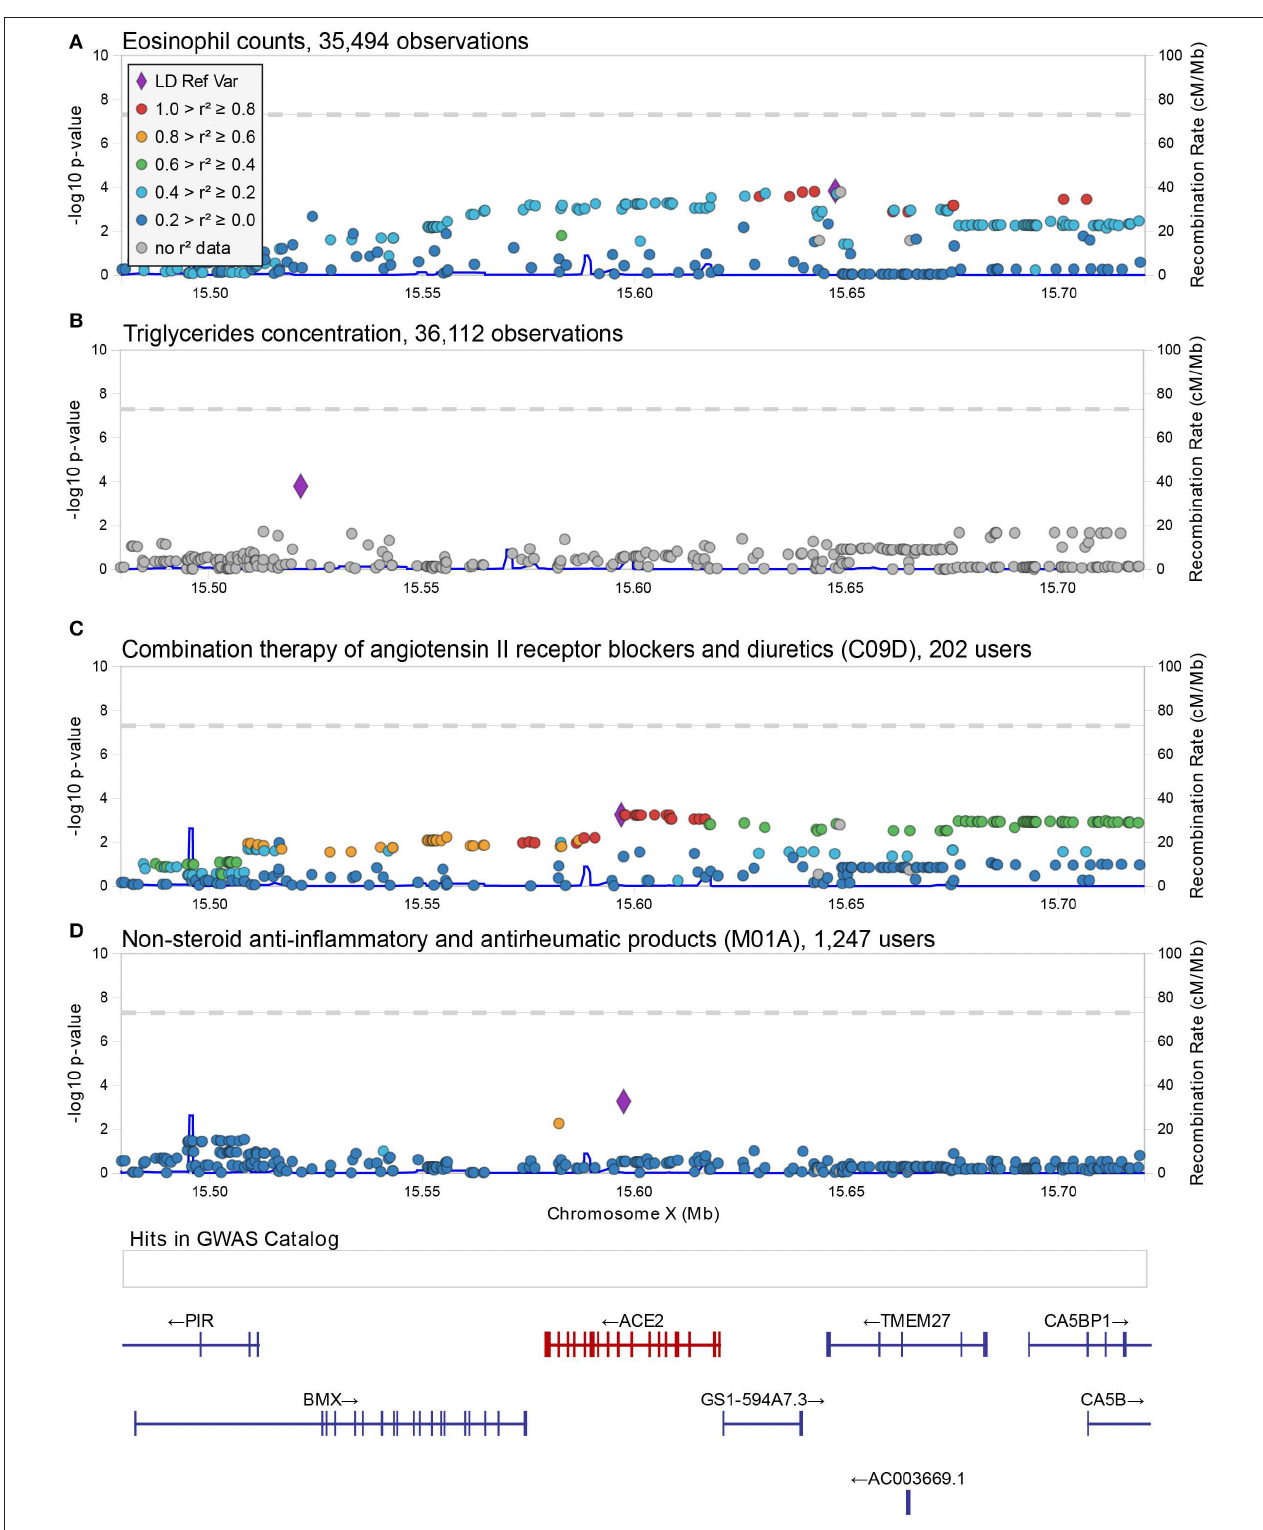
FIGURE 1 | Regional associations plot at the ACE2 locus. Graphical representation of the association results at the ACE2 locus for the SNP-trait associations reported in Table 1 (A,B) and Table 2 (C,D) . In each panel, each dot represents a genetic variant, and shown is the association strength (expressed as